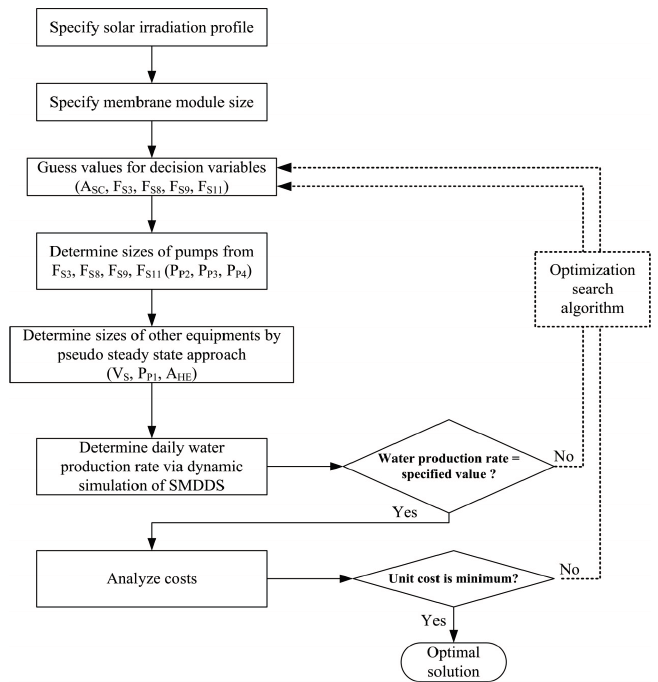
Figure 5. The systematic optimization